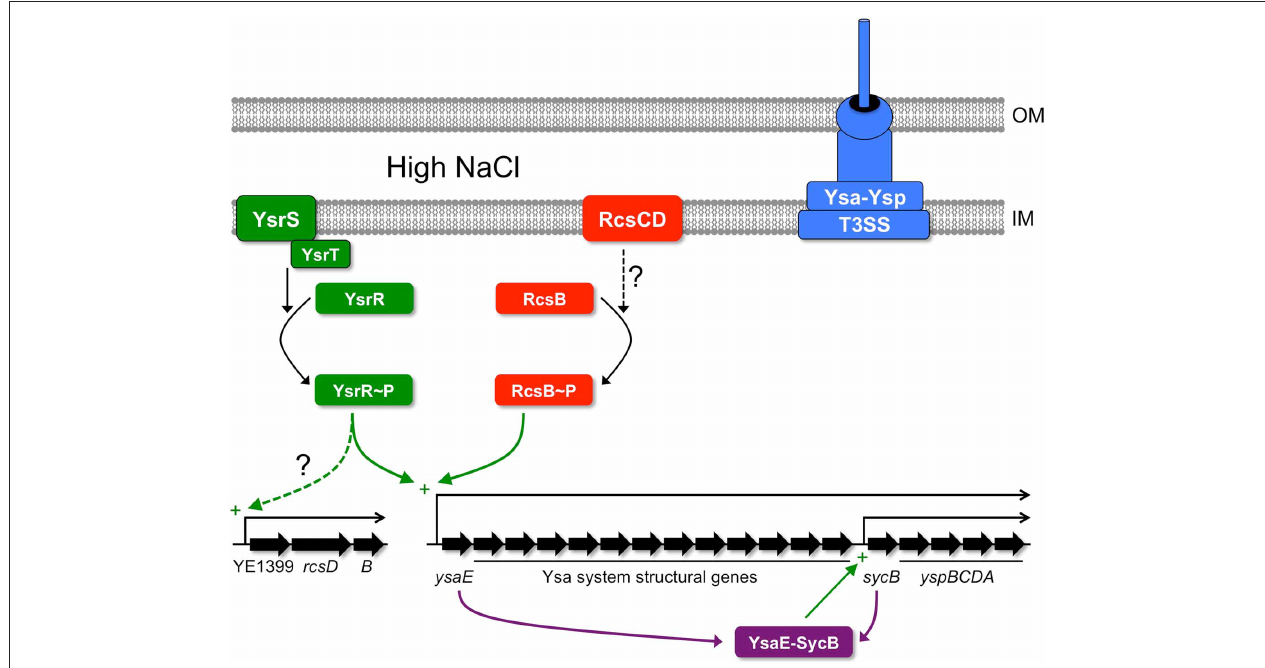
FIGURE 1 | Regulation of the Ysa-Ysp T3SS in Y. enterocolitica . Increased expression of the genes encoding the Ysa-Ysp system depends on the phosphorelay system composed of YsrS, YsrT, and YsrR. High salt might be sensed by YsrS, which then phosphorylates the response regulator YsrR (with the involvement of the accessory protein YsrT). YsrR ∼ P activates the ysaE promoter directly or indirectly. The result is increased levels of the proteins making up the Ysa-Ysp system, including the AraC-like regulator YsaE and the Ysp chaperone SycB. YsaE and SycB form a complex that activates a promoter up-stream of sycB , further elevating the levels of Ysp proteins. In addition, the YsaE-SycB complex induces other ysp genes located elsewhere on the chromosome (not shown). In addition to regulation